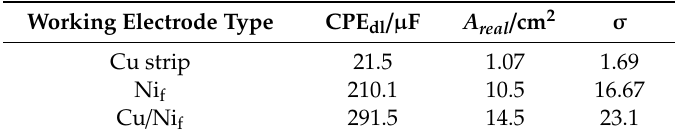
Table 3. Double-layer capacitance, real surface area and corresponding surface roughness values for the investigated Cu electrodes calculated from the EIS